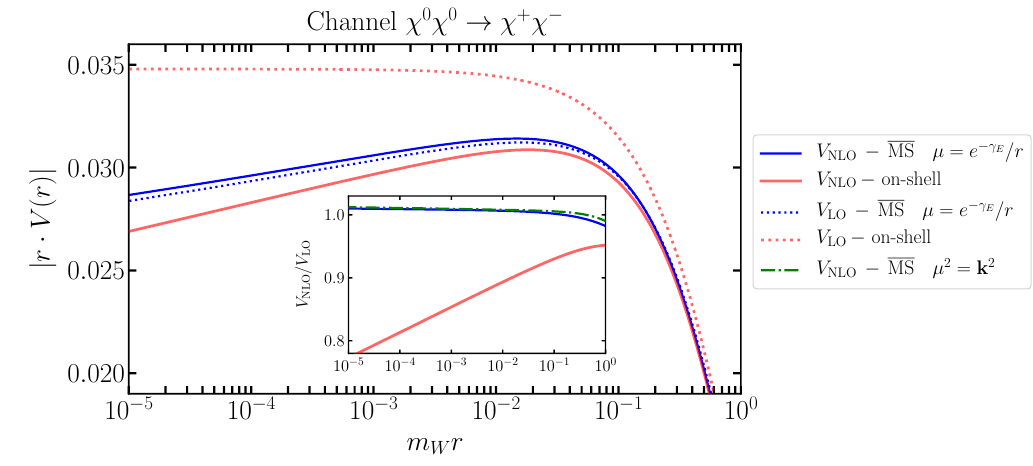
Figure 4 . The NLO (solid) and LO potential (dotted) | r · V ( r ) | in the MS -scheme using µ = e − γ E /r (blue) and in the on-shell scheme (red) for the channel χ 0 χ 0 → χ + χ − . The inset shows the ratio of the NLO potential to the LO potential for with same colour coding. In addition the dashed-dotted (green) line shows the MS -scheme potential with running coupling at µ 2 = k 2 implemented before Fourier transformation to position